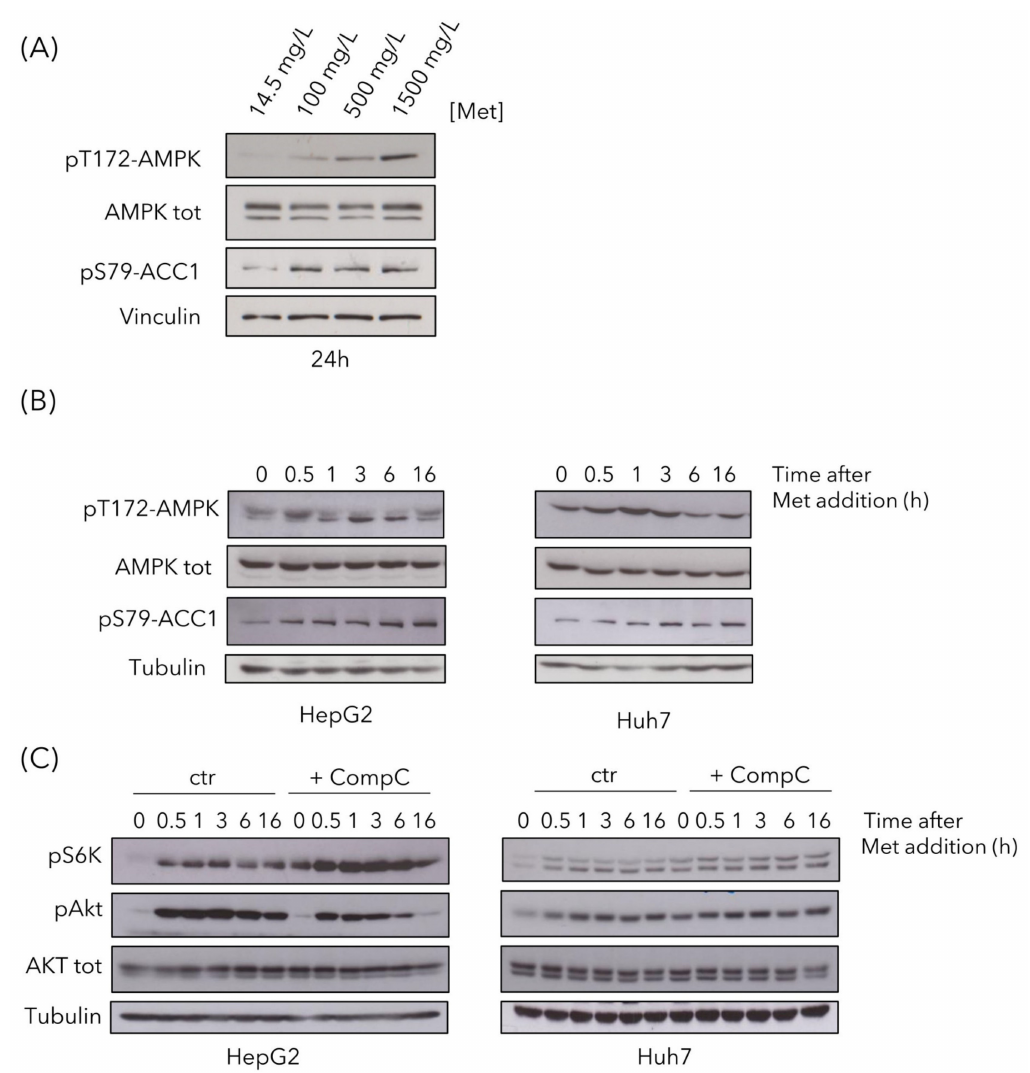
Figure 6. High methionine activates AMK-activated protein kinase (AMPK), mTOR and Akt pathways. ( A ) HepG2 were treated with methionine for 24 h and AMPK activation state was assayed by Western analysis, using the pT172-AMPK antibody (against pT172 in the activation loop) and using the anti-pS79-Acc1 antibody (against the target site of AMPK on